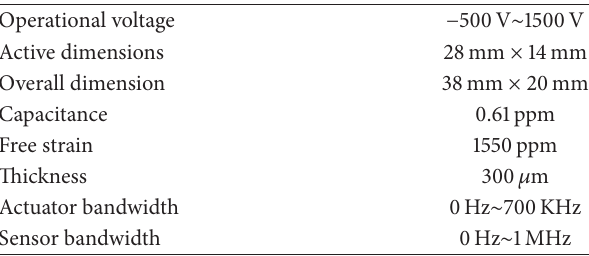
Figure 1: MFC Type P1 M2814 (made by Smart Material Corp.). Table 1: Properties of MFC Type P1 M2814.